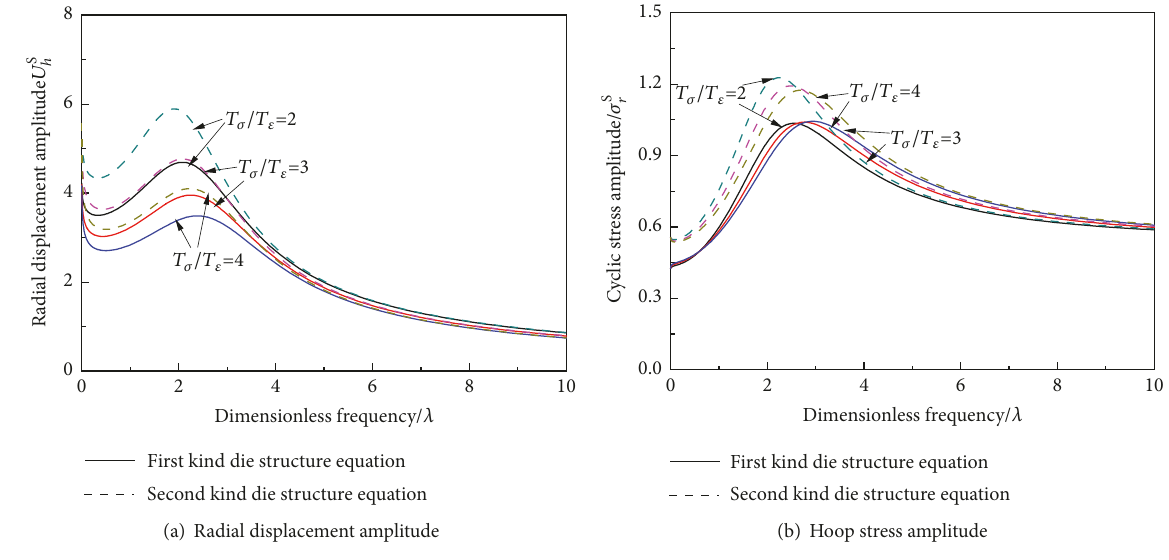
Figure 7: Influence of material parameter ratio on radial displacement and hoop stress